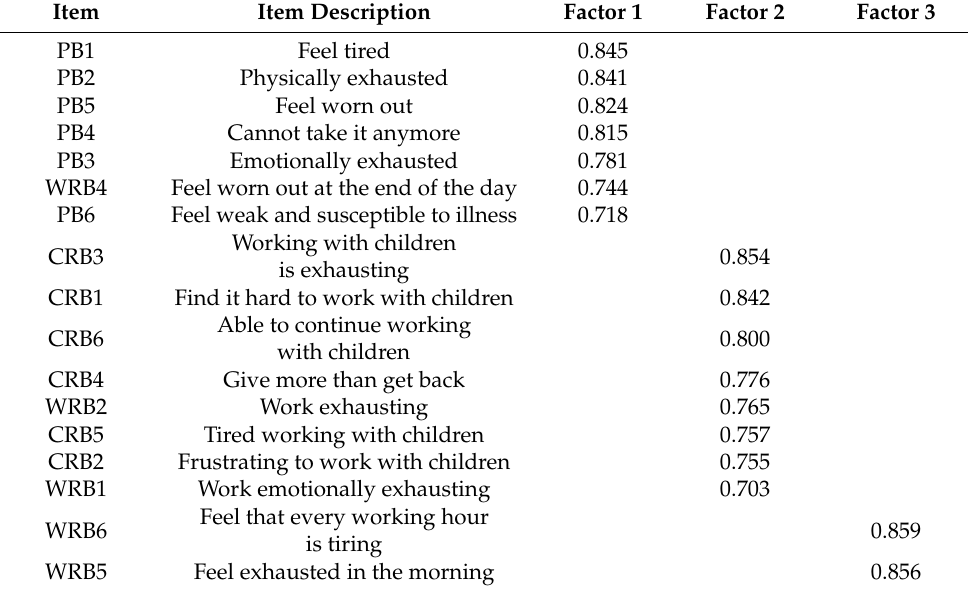
Table 3. Factors and factor loadings for each item using the principal component analysis with Promax rotation and Kaiser